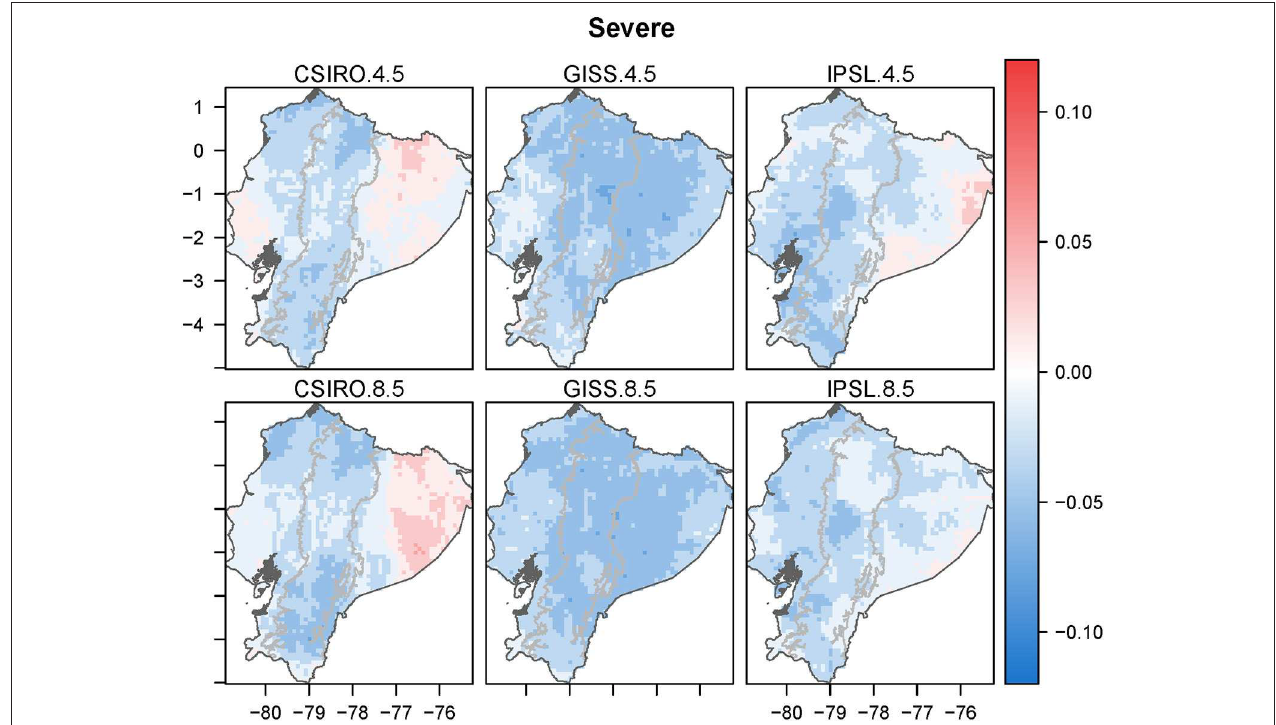
FIGURE 5 | Spatial distribution of change for severe drought probability. RCP (rows) and GCM (columns). White pixels indicate no change.